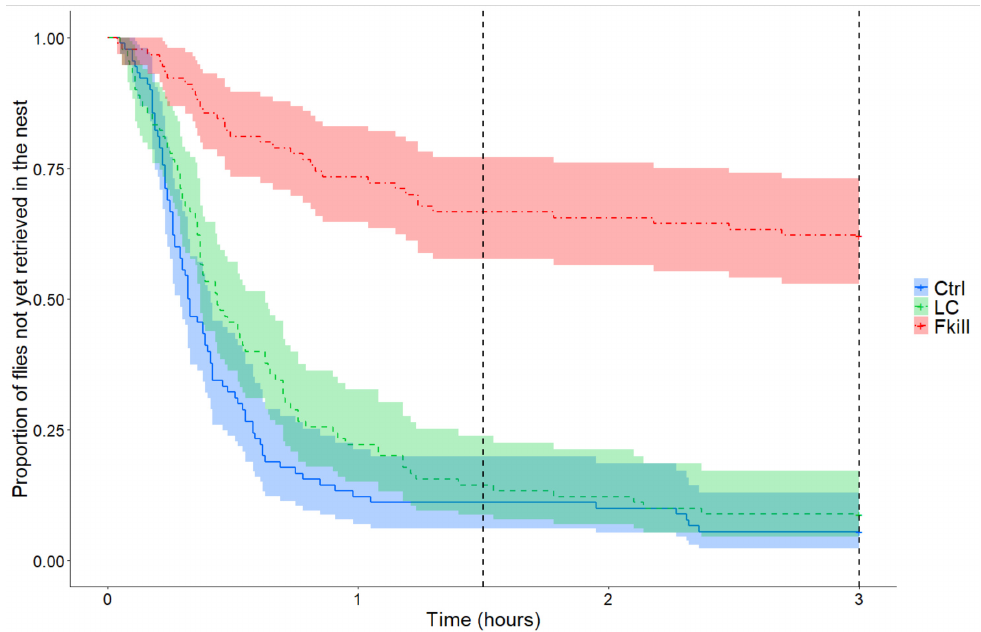
Figure 1. Proportion of flies not yet retrieved inside the nest as a function of time elapsed since prey introduction on the foraging area. The two vertical dashed lines indicate the half (i.e., 1 h 30) and the end of the experiment (i.e., 3 h). Curves are drawn for the different experimental conditions. Blue solid curve: control conidia-free flies (Ctrl, n = 90); green dotted curve: conidia-covered flies (LC, n = 90); red dashed curve: flies killed by the entomopathogenic fungus (Fkill, n = 90); The coloured shade around curves represents the 95% confidence intervals for each condition. Table 1. Prey retrieval and prey discarding as a function of their infectious state. For the retrieved flies, median, first and third quartiles values are given. The discarded flies are expressed in percentage. After general linear mixed models (GLMMs), Tukey post hoc tests were made with Bonferroni correction. Values sharing a common letter were not significantly di ff